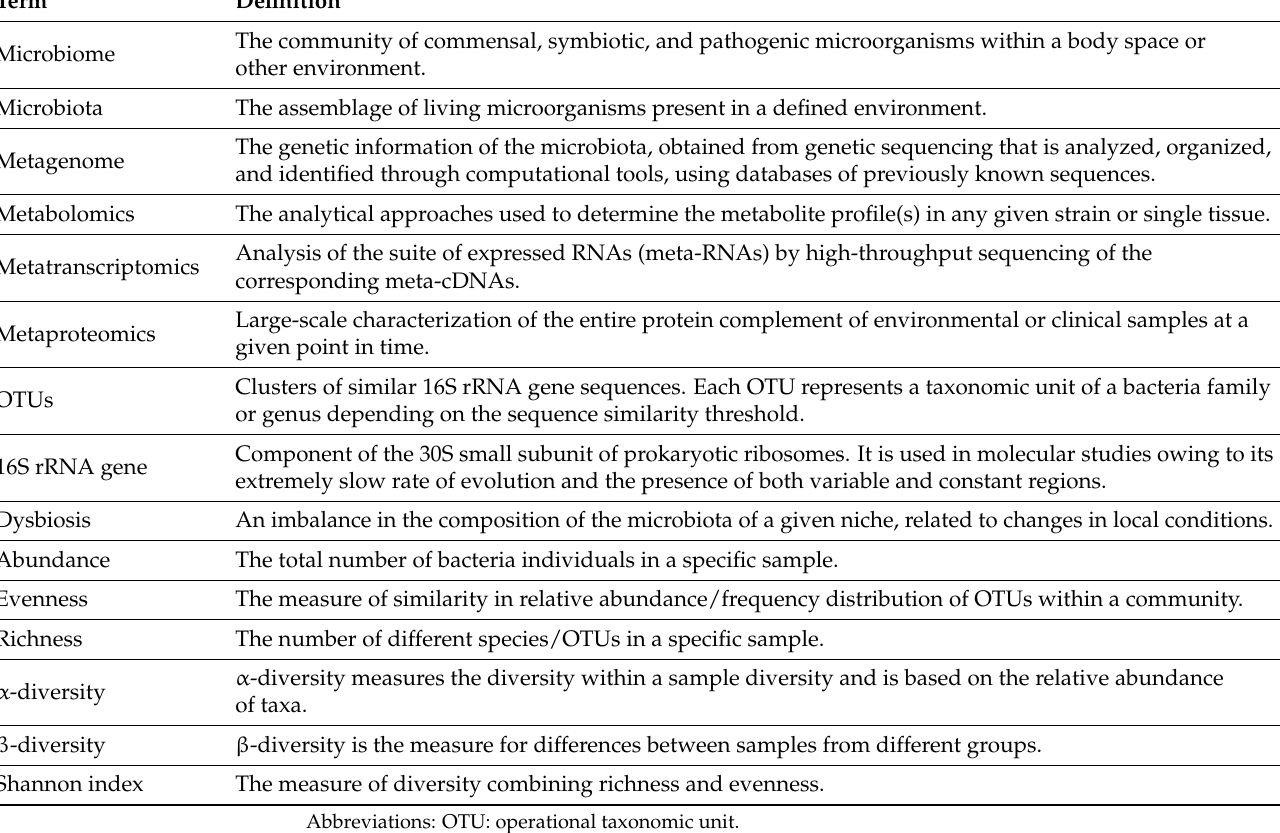
Table 1. Current microbiome terminology used